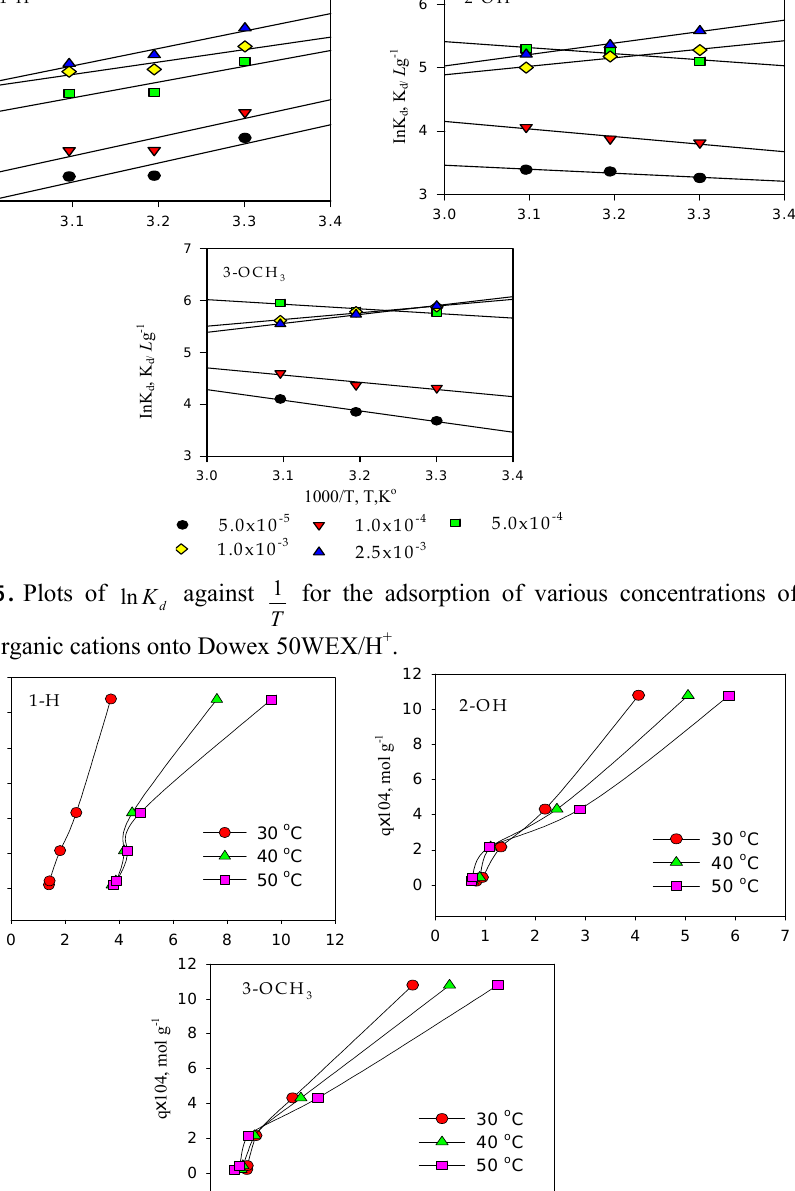
Figure 6 . Isotherms of the studied organic cations adsorbed onto Dowex 50WEX/H + at different